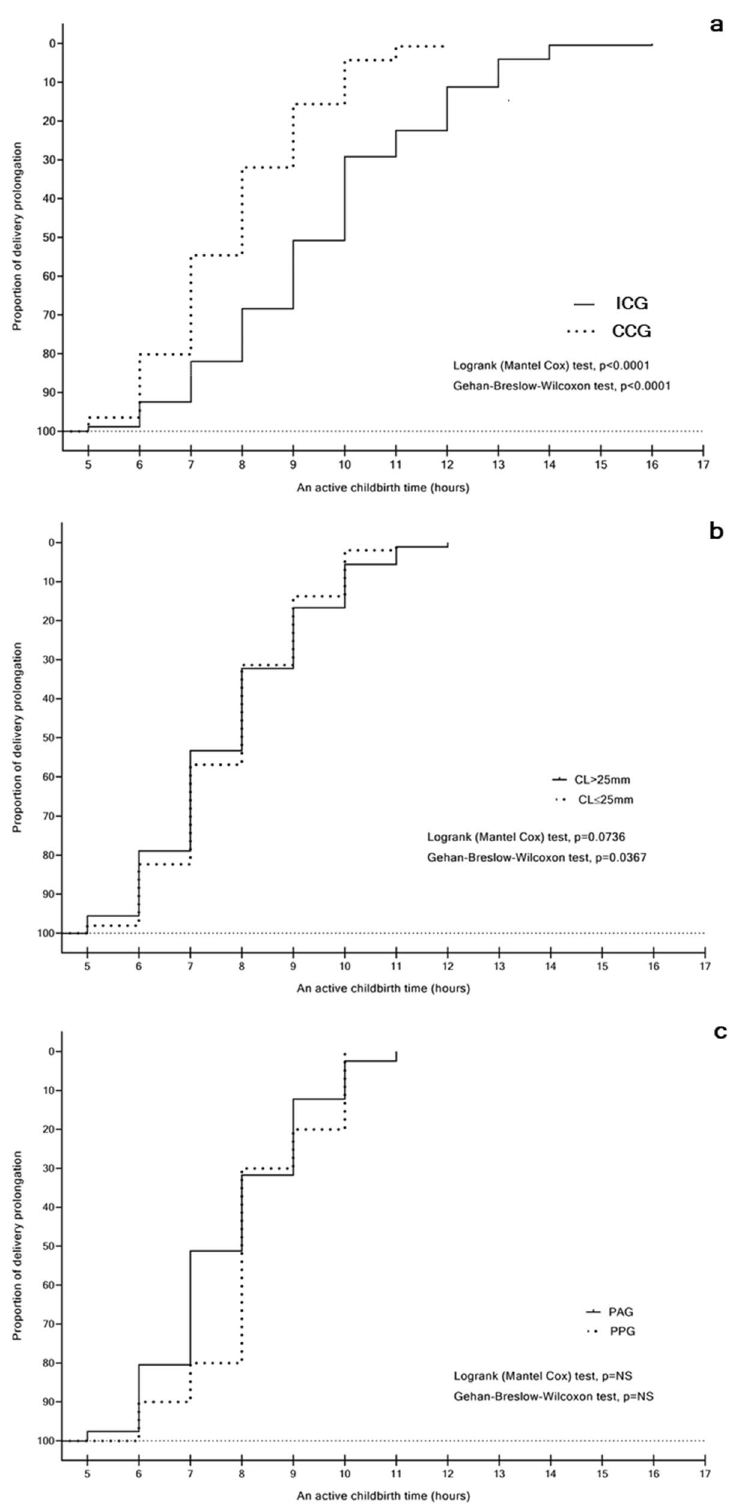
Figure 6. The delivery prolongation curve, (unit: survival curve in hours of the proportion of delivery prolongation) in asymptomatic women with singleton pregnancies: ( a ) Intact Cervix (ICG) vs. Cervical Conization (CCG), groups; ( b ) Adequate cervical length (CL > 25 mm) vs Short cervix (CL ≤ 25 mm), groups; ( c ) Progesterone-only (POG) vs Progesterone-Pessary (PPG),